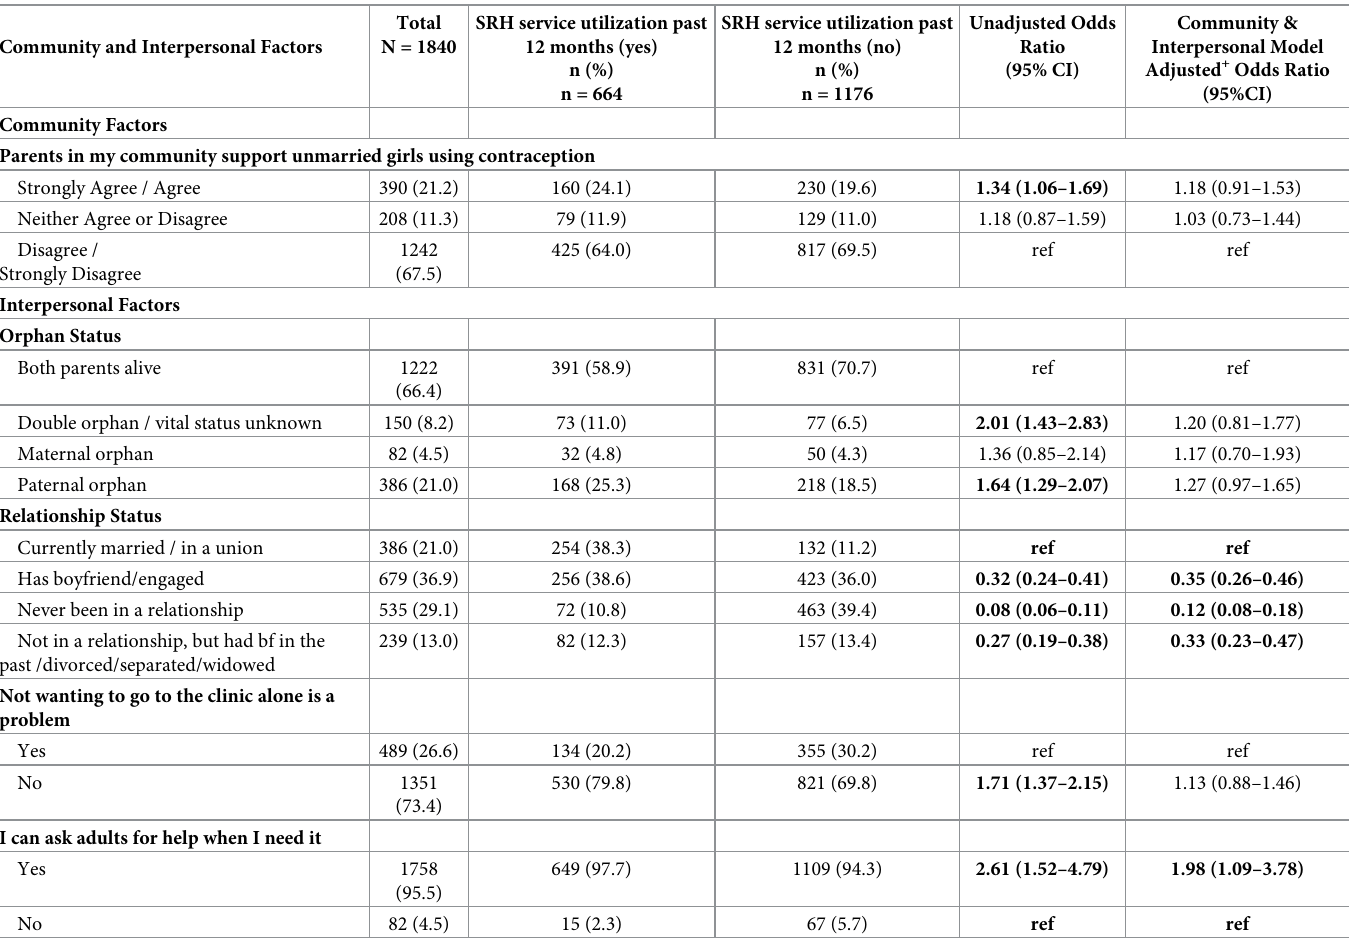
Table 4. Community and interpersonal factors associated with SRH utilization among adolescents aged 15–19 in Kenya. Community and Interpersonal